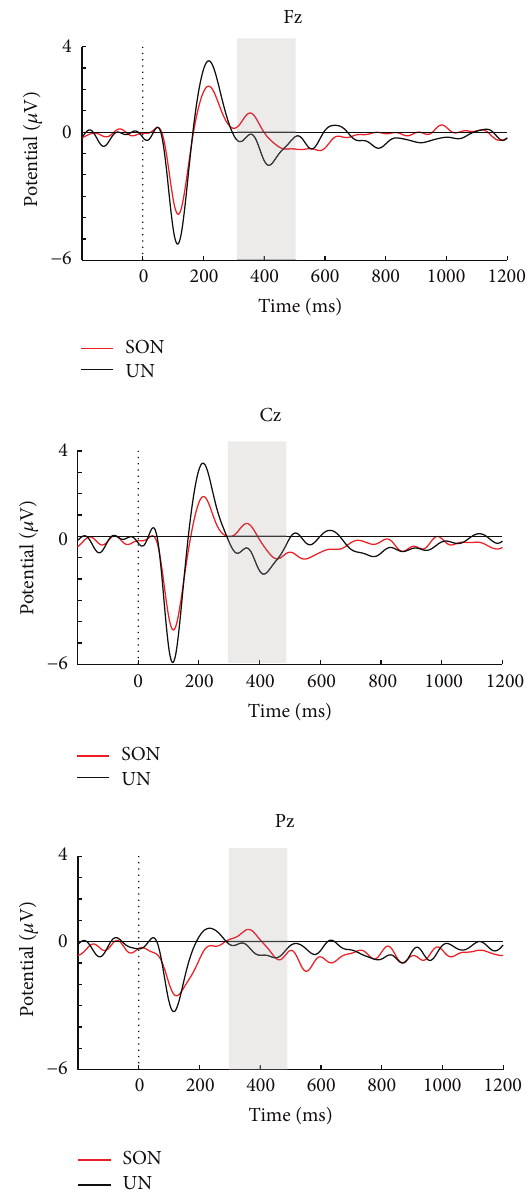
Figure 2: Stimuli SON and UN in passive listening task for the healthy